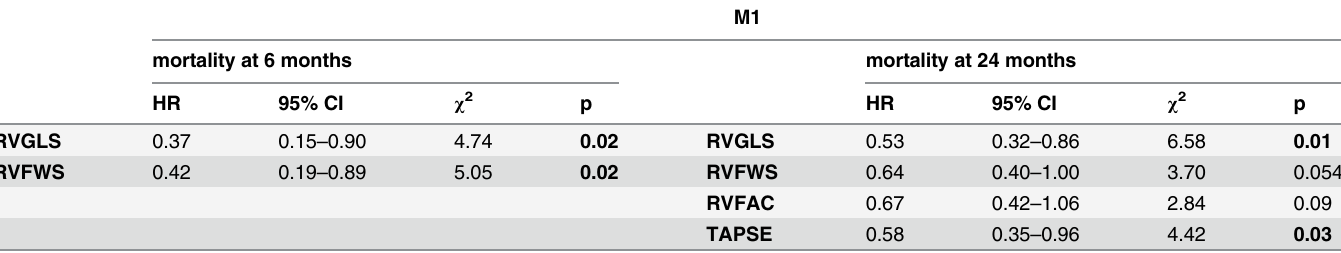
Hazard ratios refer to 1 standard deviation increase. Models were adjusted for QRS duration, intake of beta blocker and aldosterone antagonist in case of mortality at 6 months and QRS duration and left atrial volume in case of mortality at 24 months. HR: hazard ratio, CI: con fi dence interval, χ 2 : wald chi square, OR: odds ratio, RVGLS: right ventricular global longitudinal strain.